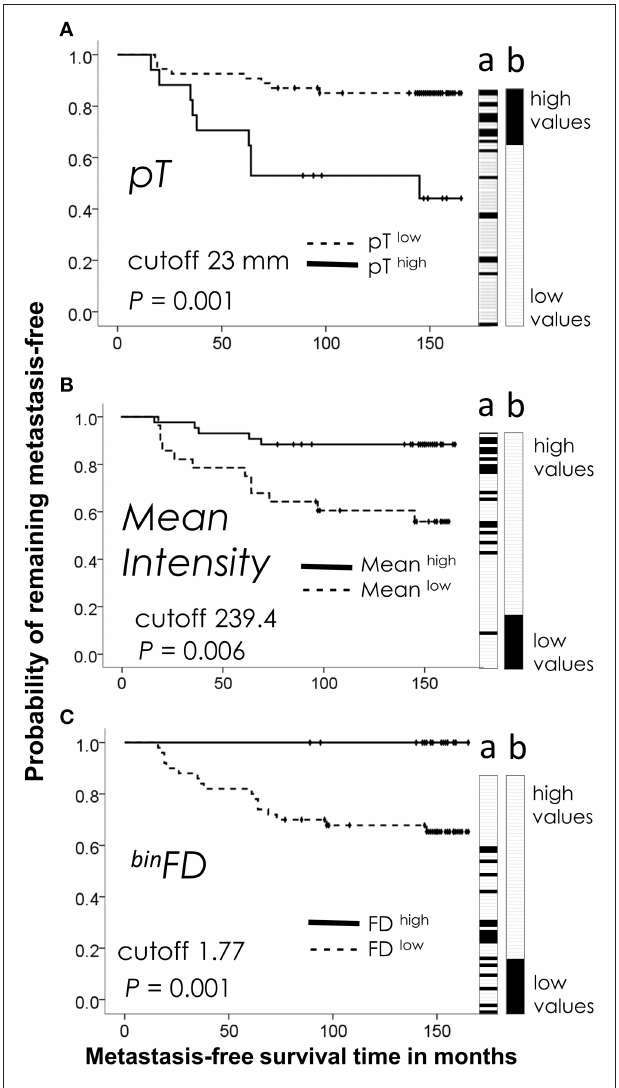
FIGURE 1 | Kaplan-Meier analysis of the best performing feature from each group: (A) clinicopathological (tumor size, pT ), (B) immunostaining intensity ( mean pixel intensity), (C) fractal ( bin FD ). Plots reveal prognostic discrimination efficiencies of feature values categorized by indicated cutpoint values. Dotted lines show the patient subgroup with lower feature values (below the cutpoint, feature low ). Feature high value subgroup is plotted on solid lines. (a) Ordering of patients by the ascending continuous values of each feature. Patients with metastasis are indicated by black tiles and patients without metastasis by white tiles. Lane a thus illustrates the prognostic performance of each feature to stratify the patients (a) into high and low risk groups by their continuous values, while Kaplan-Meier plots indicate the prognostic performance after categorization of feature values. (b) The ideal stratification of the actual metastasis occurrence is shown for comparison. The time refers to the interval from a primary breast tumor surgery until the occurrence of first distant metastasis or end of follow-up. P -values were calculated by the Cox proportional hazards